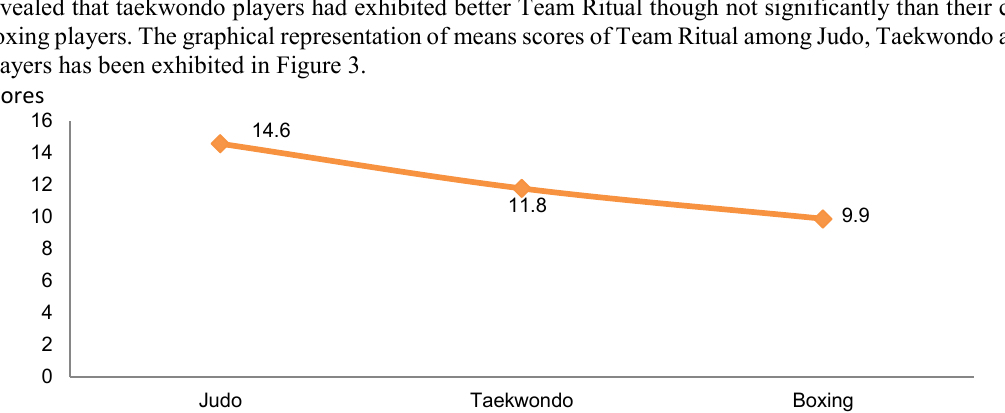
Figure 3. Graphical representation of mean scores with regard to judo, taekwondo and boxing players on the sub-parameter team ritual Table 14. Descriptive analysis among judo, taekwondo and boxing players on the sub-parameter prayer S.